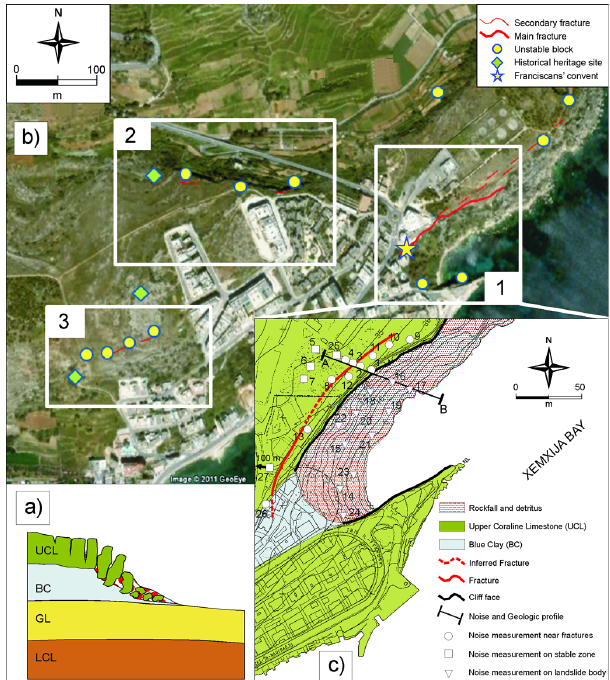
Fig. 2. (a) Schematic sketch of lateral spreading effects along the Xemxija coast; (b) view of the Xemxija Bay area showing the sites investigated in the geomorphological survey; and (c) geo-lithologic map of the northeastern part of the Xemxija Bay (modified from Various Authors,